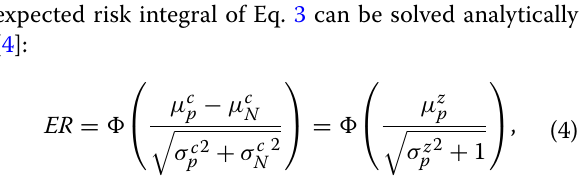
SpERC Specific Environmental Release Category; from Van de Meent et al.